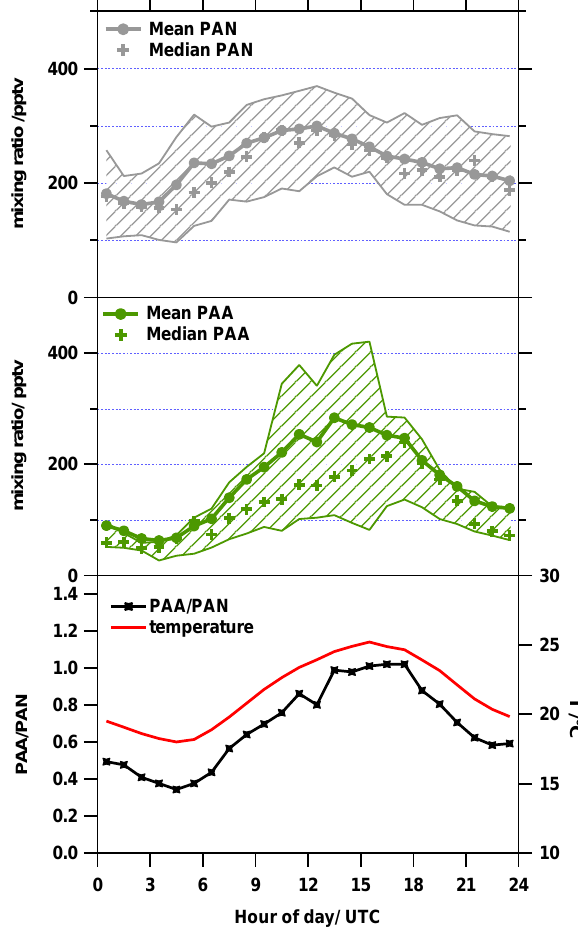
Fig. 6. Diel PAN (top panel) and PAA (middle panel) profiles dur- ing HUMPPA-COPEC-2010. The range (25–75th percentile) is in- dicated by the hatched area. The bottom panel shows the diel PAA- to-PAN ratio alongside the diel temperature during the campaign.